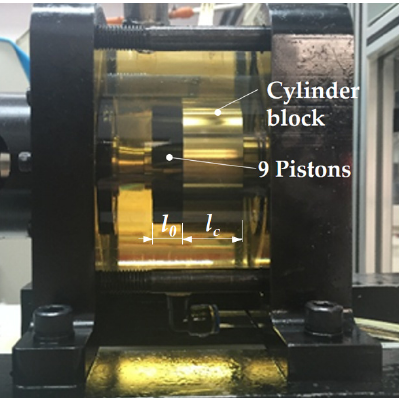
Figure 3. Oil flow around the pistons and cylinder block.